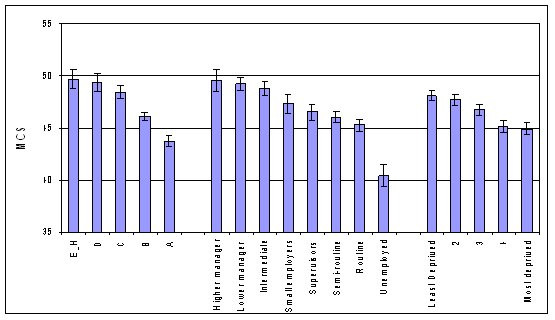
Mental (MCS) component summary mean scores with 95% confidence intervals by categories of CTVB, NS-SEC and fifths of the distribution of ward Townsend scores. Adjusted for age and gender.